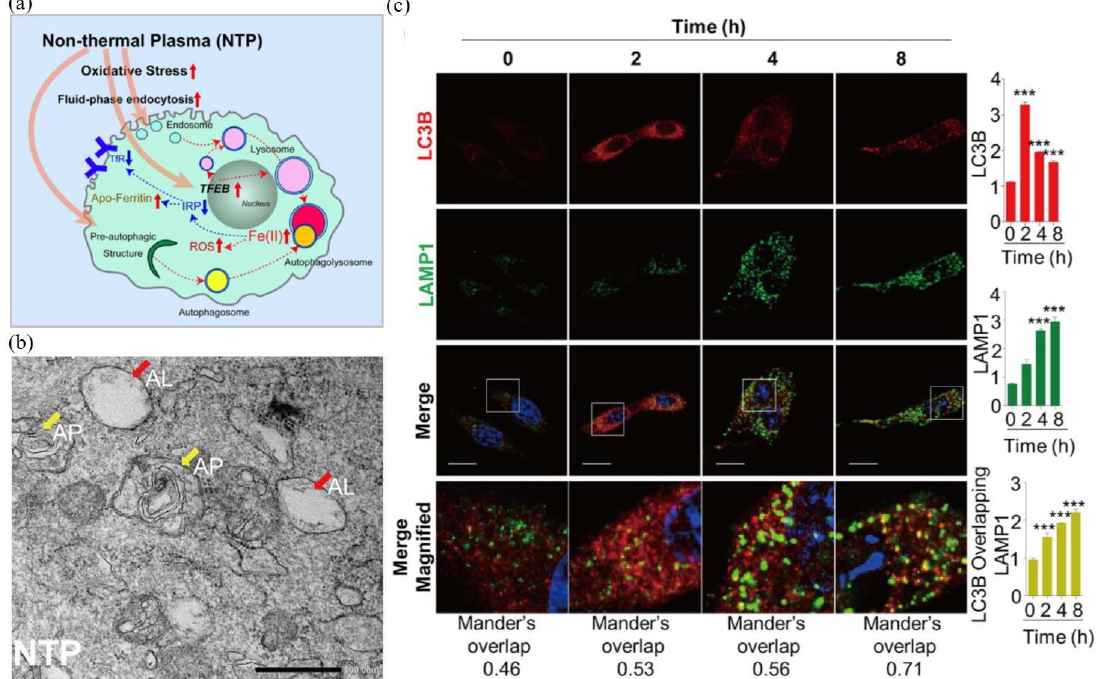
Figure 4. CAP induces oxidative stress response in malignant mesothelioma cells (SM2), resulting in increased endocytosis, lysosome biogenesis, and autophagy-associated cell death. ( a ) Schematic autophagy mechanism of the CAP-treated malignant mesothelioma cells. ( b ) TEM imaging of vesicle structures, endosome-like vesicles, and organelles involved in the autophagic pathway of the CAP-treated SM2 cells (60 s). Yellow and red arrowhead indicates AP and AL, respectively. Scale bar = 500 nm. ( c ) Fluorescent imaging of the formation of autophagosomes in the CAP-treated (60 s) malignant mesothelioma cells. Cells were stained by DAPI (DNA, blue), LC3B (red), and LAMP1 (green). LC3B suggested the presence of autophagosomes, while the colocalization of LC3 and LAMP1 suggests the autophagolysosome formation (yellow overlay fluorescence). Scale bar = 20 μm. ***, p < 0.001 [104].